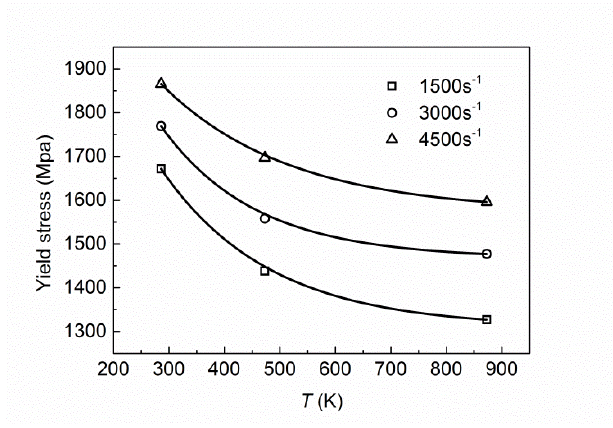
Figure 11. Effect of initial ambient temperature on yield stress ( 𝜀 𝑝 = 0.002 ) at different strain rate.